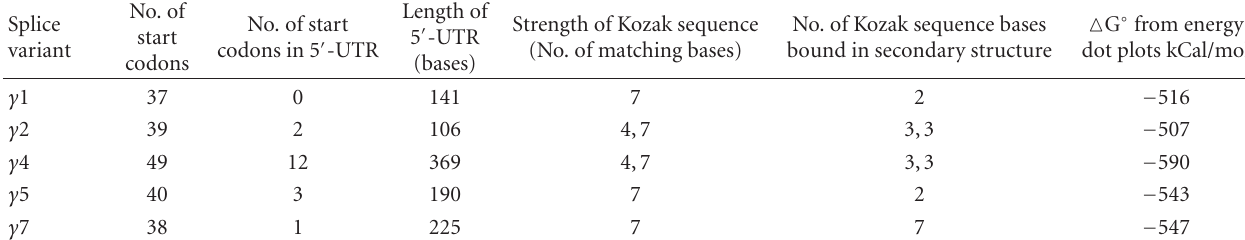
Table 2: Comparison of structural elements of 5 (cid:2) -UTRs of PPAR- γ transcript isoforms.